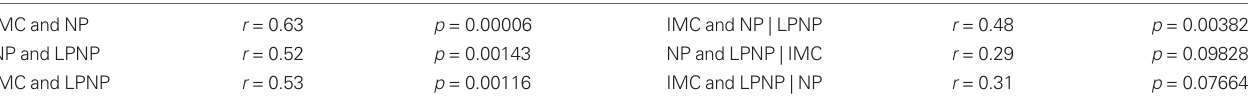
Table 1 | Correlations and partial correlations between initial magazine checking (iMC), nose poke success (NP) and lever press–nose poke performance